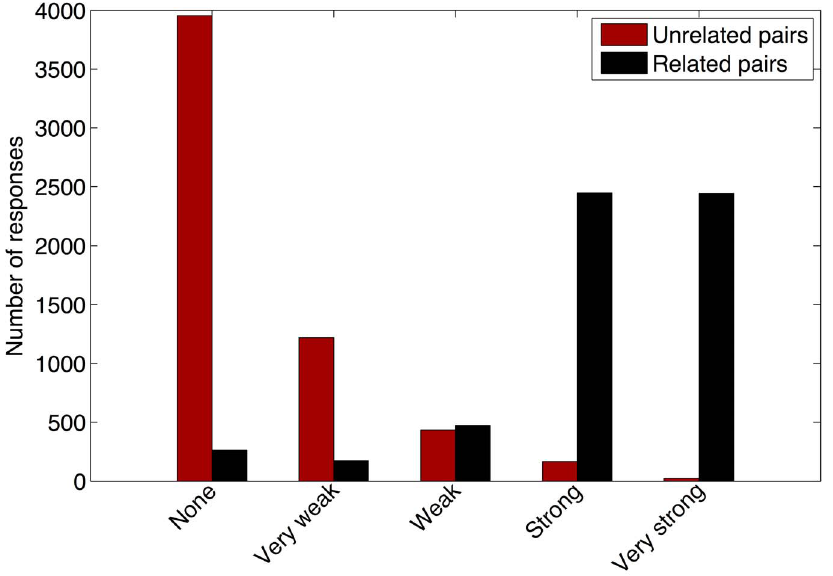
Figure 1. Histogram of perceived relation between word pairs of both sets. The 5-point scale on degree of relatedness is on the x-axis and the number of responses per pre-determined category, related (black) versus unrelated (red), is on the y-axis.